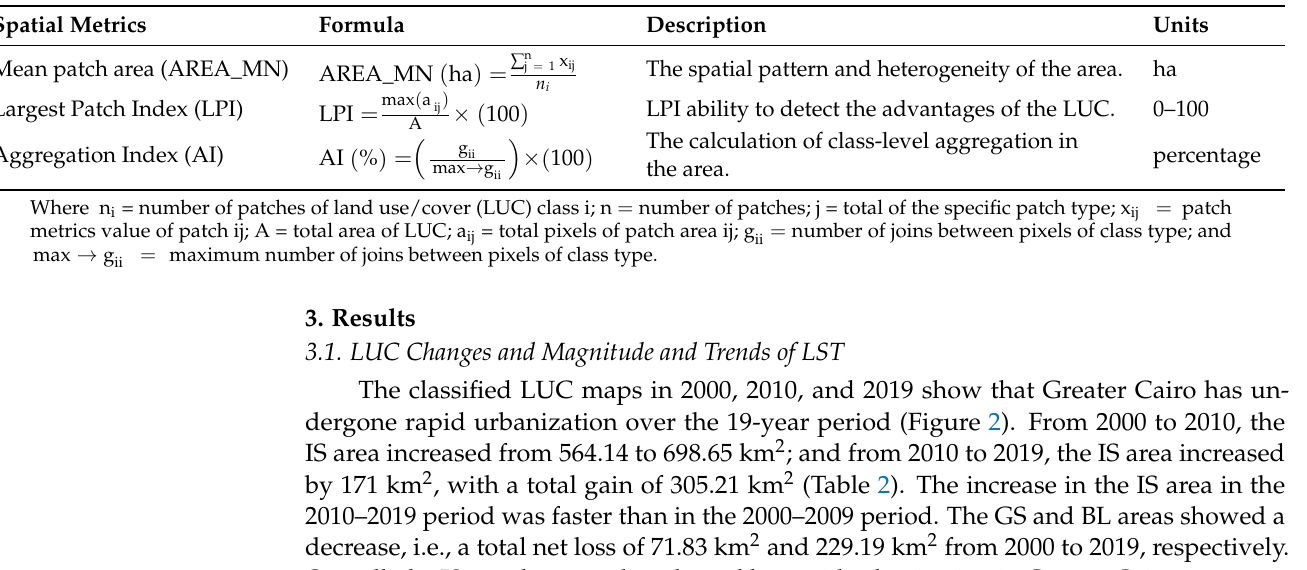
Table 1. Class-level metrics used in this study [102].